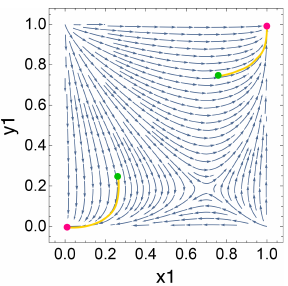
Figure A1. Evolutionary behavior for n = 0, ˙ n = 0 with theoretical GameState payoff, see Figure 1. In this visualization, green represents initial condition, yellow represents the evolutionary path and red represents the final system position at an ESS. Two evolutionary journeys are visualized with initial conditions ( 1 , 1 ) and ( 3 , 3 ). 4 4 4 4